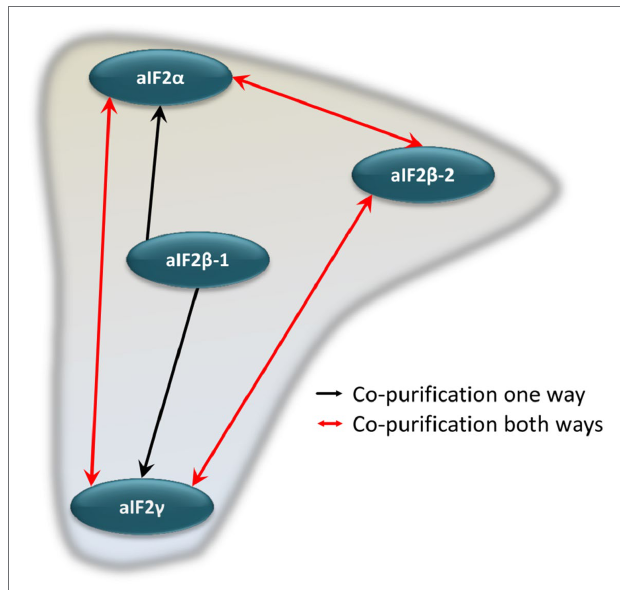
FIGURE 3 | Schematic overview of the internal aIF2 subunit interaction network. Red arrows denote reciprocal co-purification, while black arrows depict one-directional